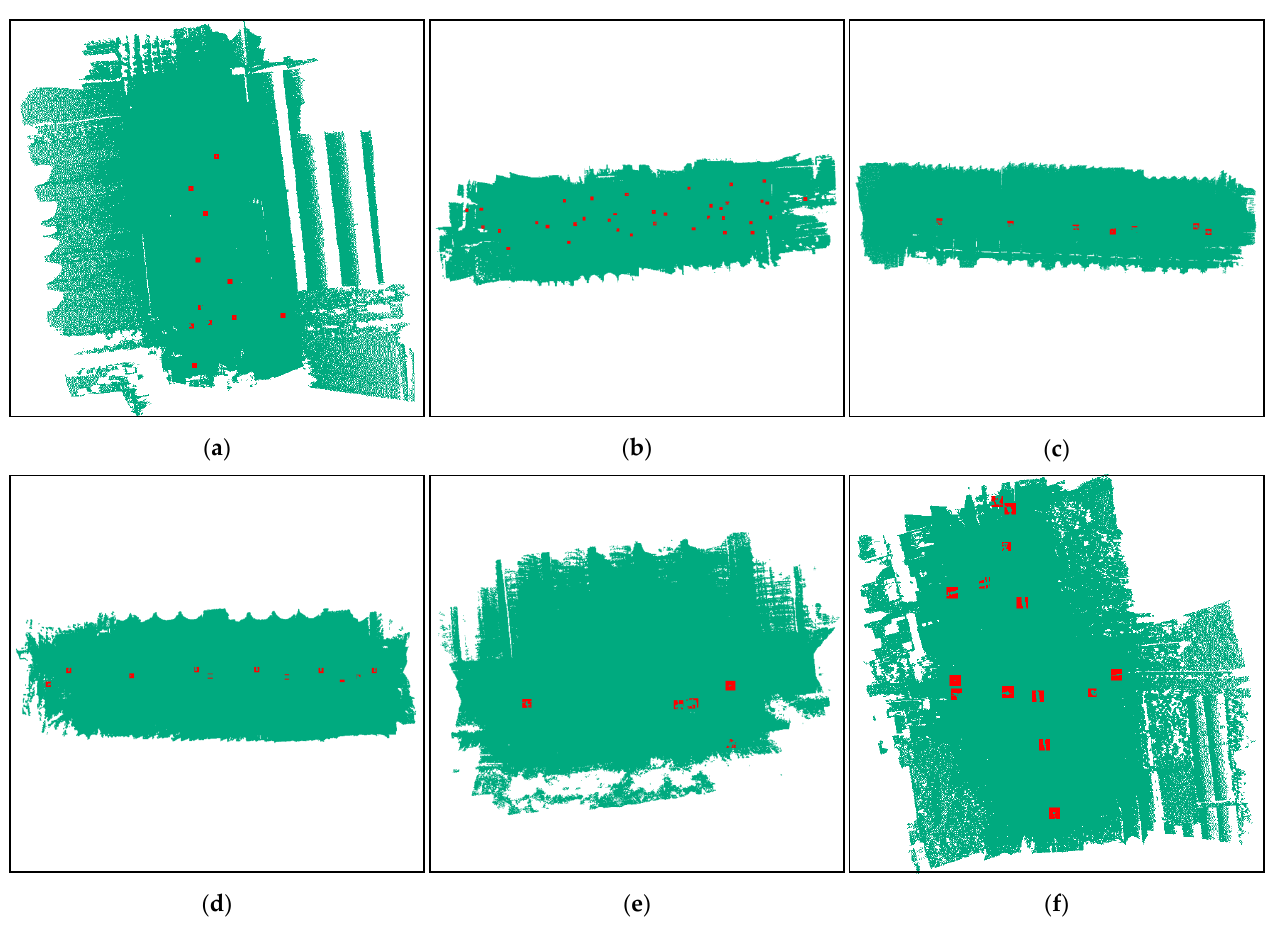
Figure 12. Locating results of telegraph poles. ( a ) Dataset-I. ( b ) Dataset-II. ( c ) Dataset-III. ( d ) Dataset-IV. ( e ) Dataset-V. ( f ) Dataset-VI.